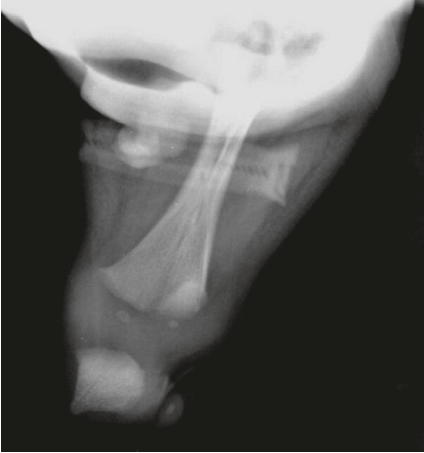
Figure 3: Lower limb X-ray showing complete fusion of both